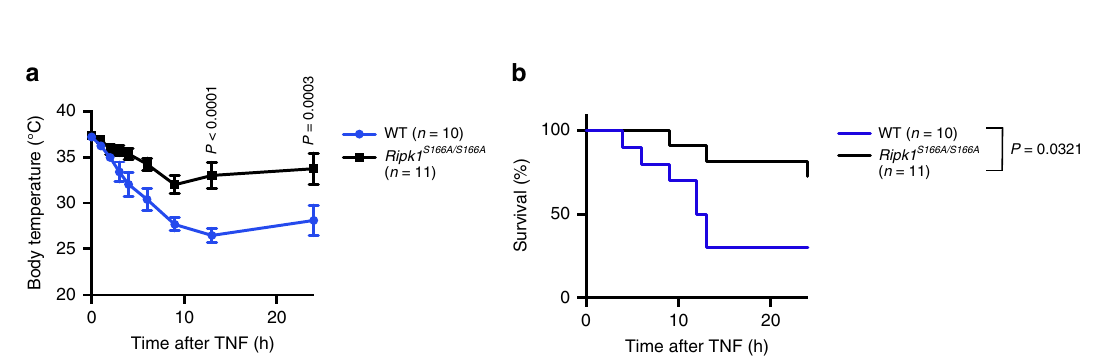
Fig. 5 S166 phosphorylation is essential for RIPK1-dependent skin in fl ammation in Sharpin cpdm/cpdm mice. a Kaplan-Meier curve of lesion-free survival of mice of the indicated genotypes. b Representative macroscopic pictures of mice of the indicated genotypes at the age of 15 – 17 weeks. c Representative skin sections from mice of the indicated genotypes at the age of 15-17 weeks stained with H&E or immunostained with antibodies against cleaved caspase- 3 (CC3), keratin 6 (K6), keratin 10 (K10), keratin 14 (K14), F4/80 and DAPI (DNA stain). Scale bars in H&E and CC3 pictures 50 μ m, in K6, K10/K14 and F4/80 pictures 20 μ m. d Graphs depicting relative mRNA expression of the indicated genes in RNA from whole skin tissue of mice of the indicated genotypes at 15 – 17 weeks of age, measured by qRT-PCR. The dots in the graphs represent individual mice. Mean± s.e.m. is shown for each group of mice in all graphs. Statistical signi fi cance was determined using a Kruskal-Wallis test (one-sided). e Representative images of H&E stained tissue sections from liver and lung from mice of the indicated genotypes at 15 – 17 weeks. Scale bars, 100 μ m. Source data for a , d are provided as a source data fi le.